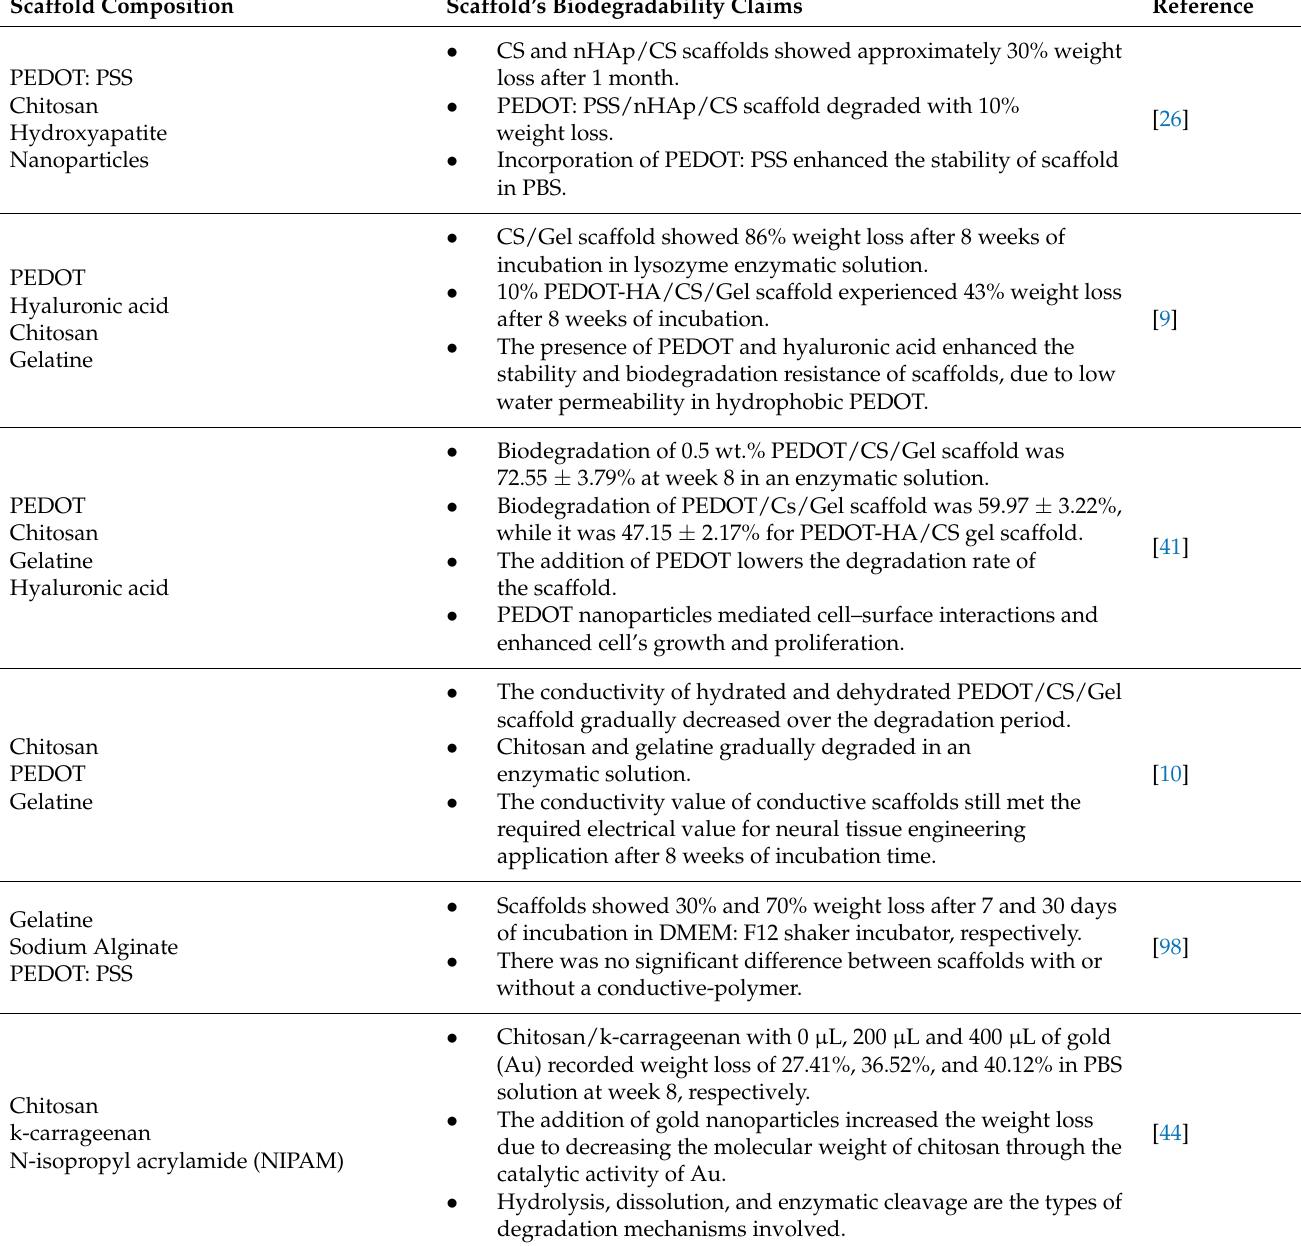
Table 3. Biodegradation index of various composite